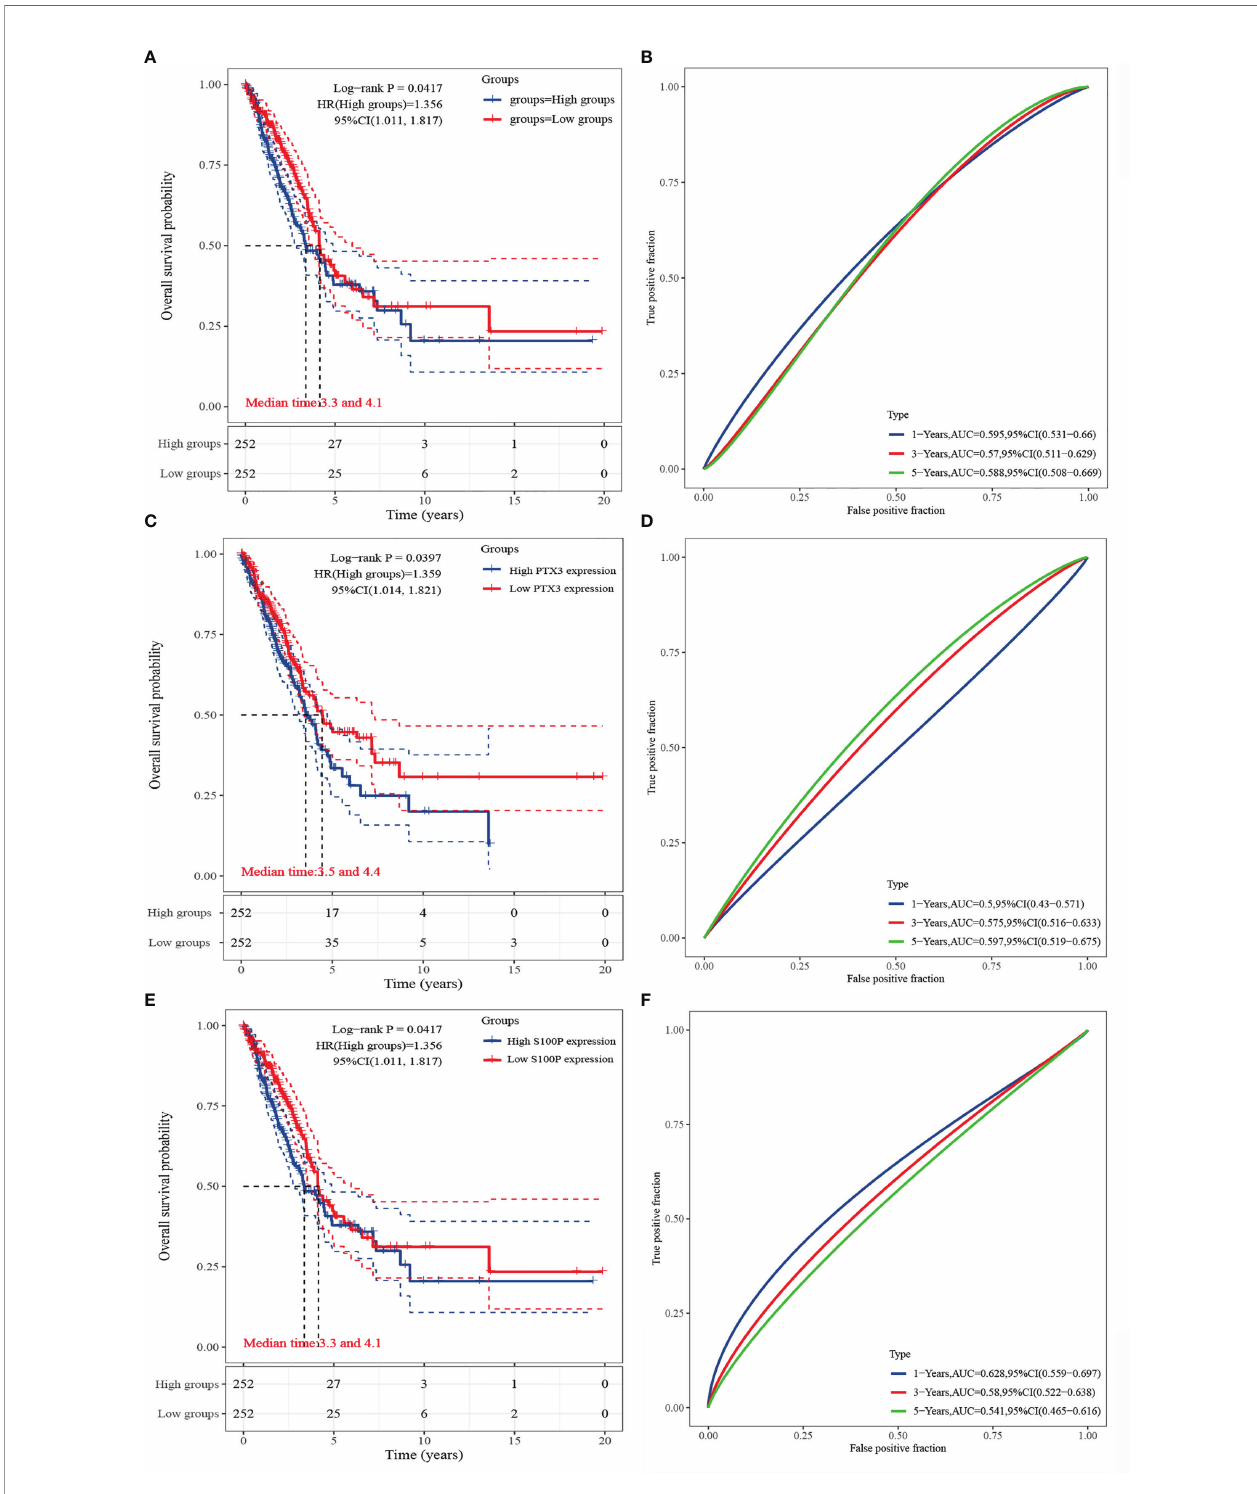
FIGURE 6 | Survival analysis of HGF, PTX3, and S100P. (A) KM curve of HGF; (B) ROC curve of HGF; (C) KM curve of PTX3; (D) ROC curve of PTX3; (E) KM curve of S100P; (F) ROC curve of